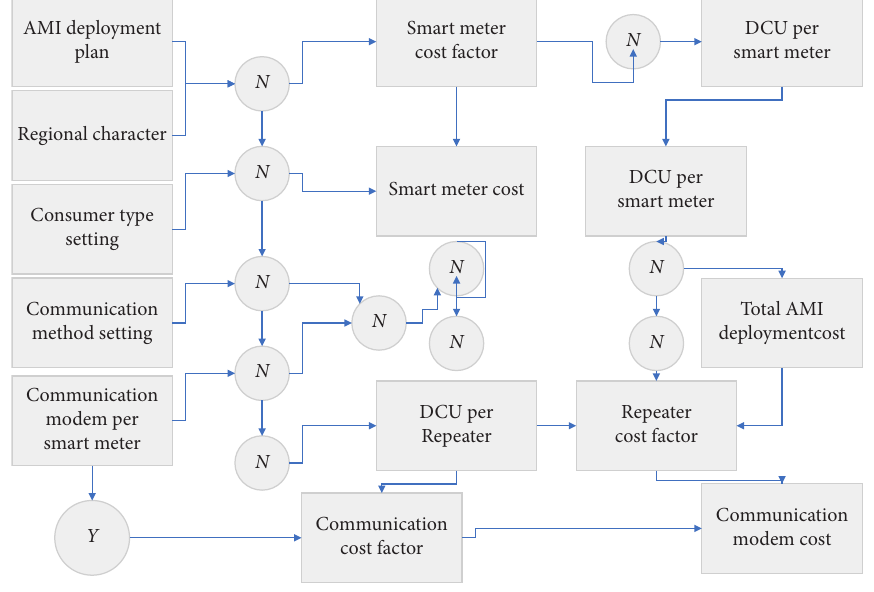
Figure 3: Flow chart of landscape data operation